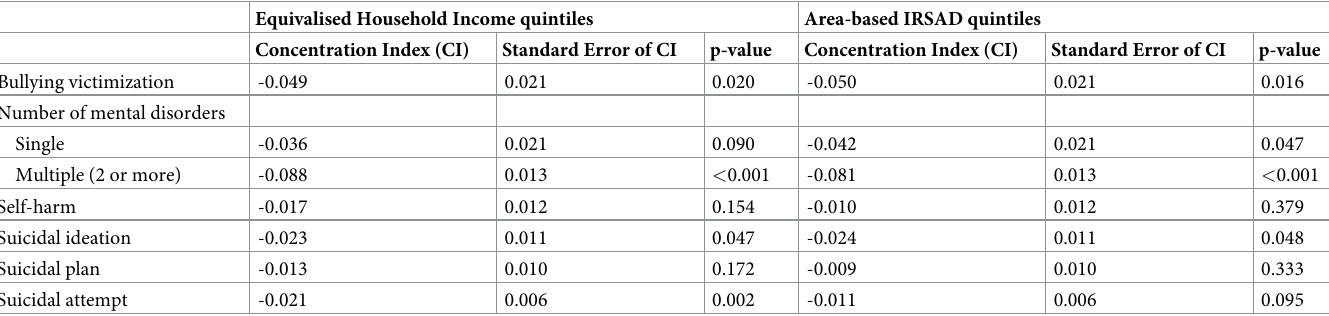
Table 3. The Erreyger’s CIs for mental health problems among Australian adolescents (12–17